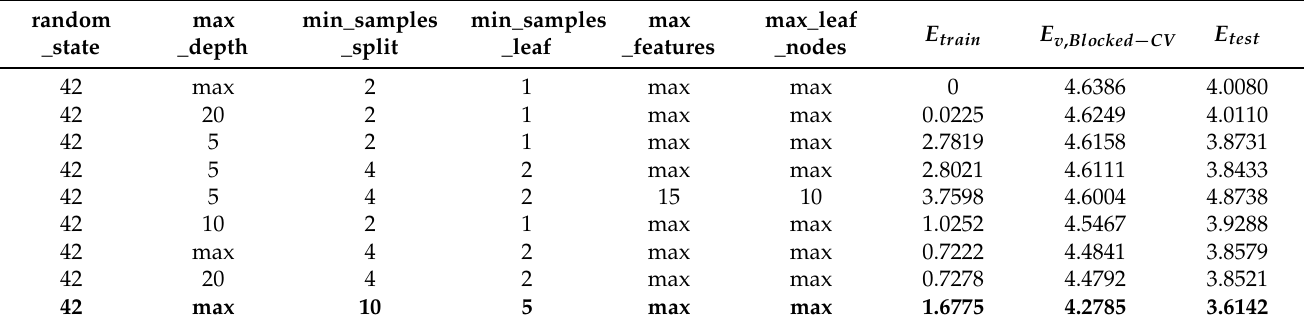
Table A3. Performance of the DT model with different sets of hyper-parameters (Group